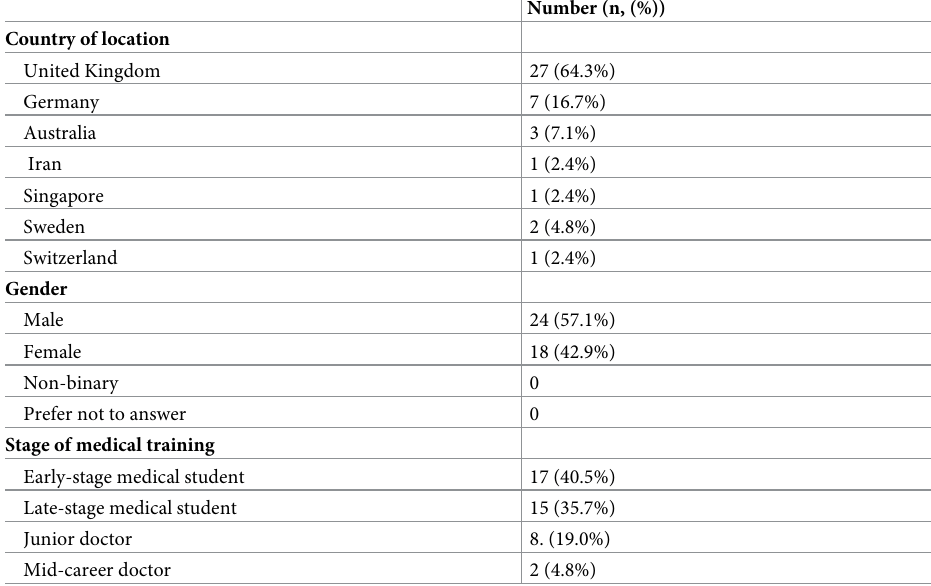
Table 2. Demographic characteristics of fellowship participants (n =